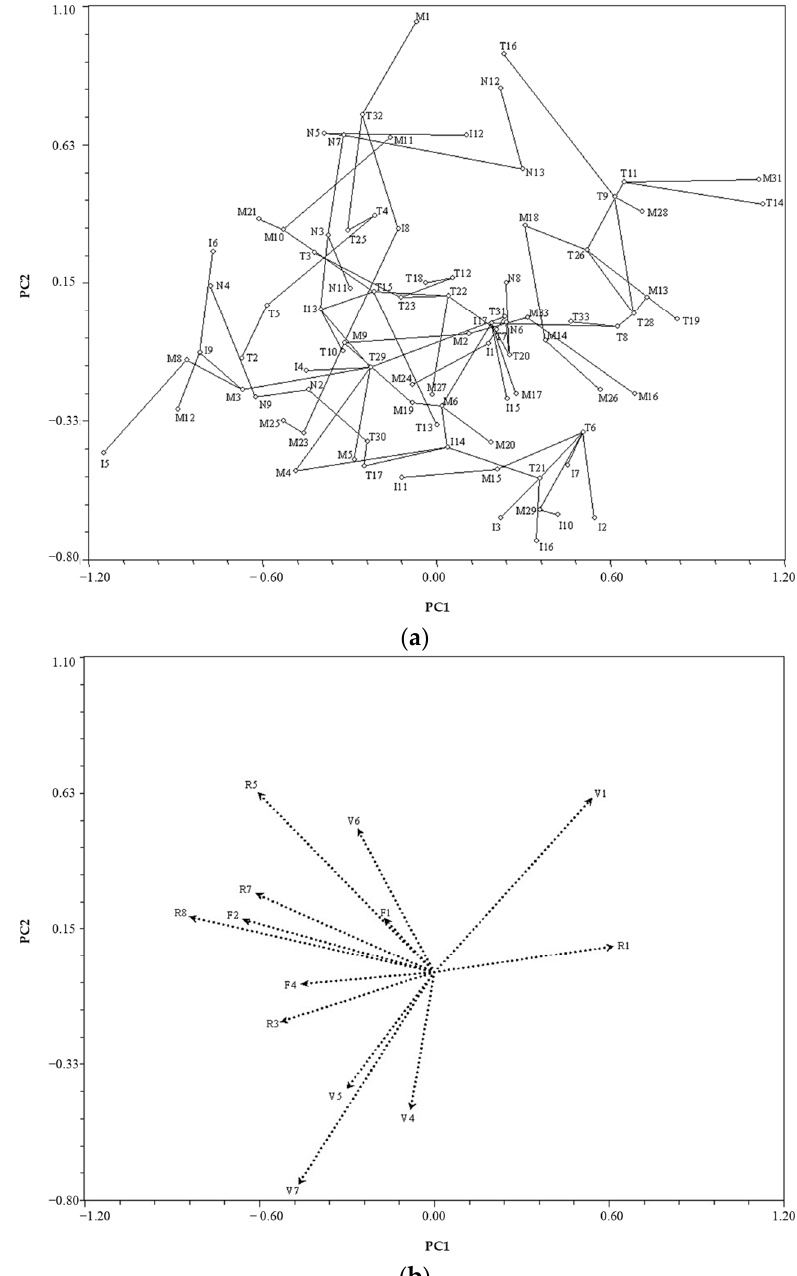
Figure 3. ( a ) PC 1 and PC 2 projection plots of the 87 tropical species (listed in Tables 1 and 3) based on anatomical wood characteristics (coded in Table 2), overlapped with the MST method (r = 0.87). ( b ) The correlation degree between the variables based on the position of the vector.